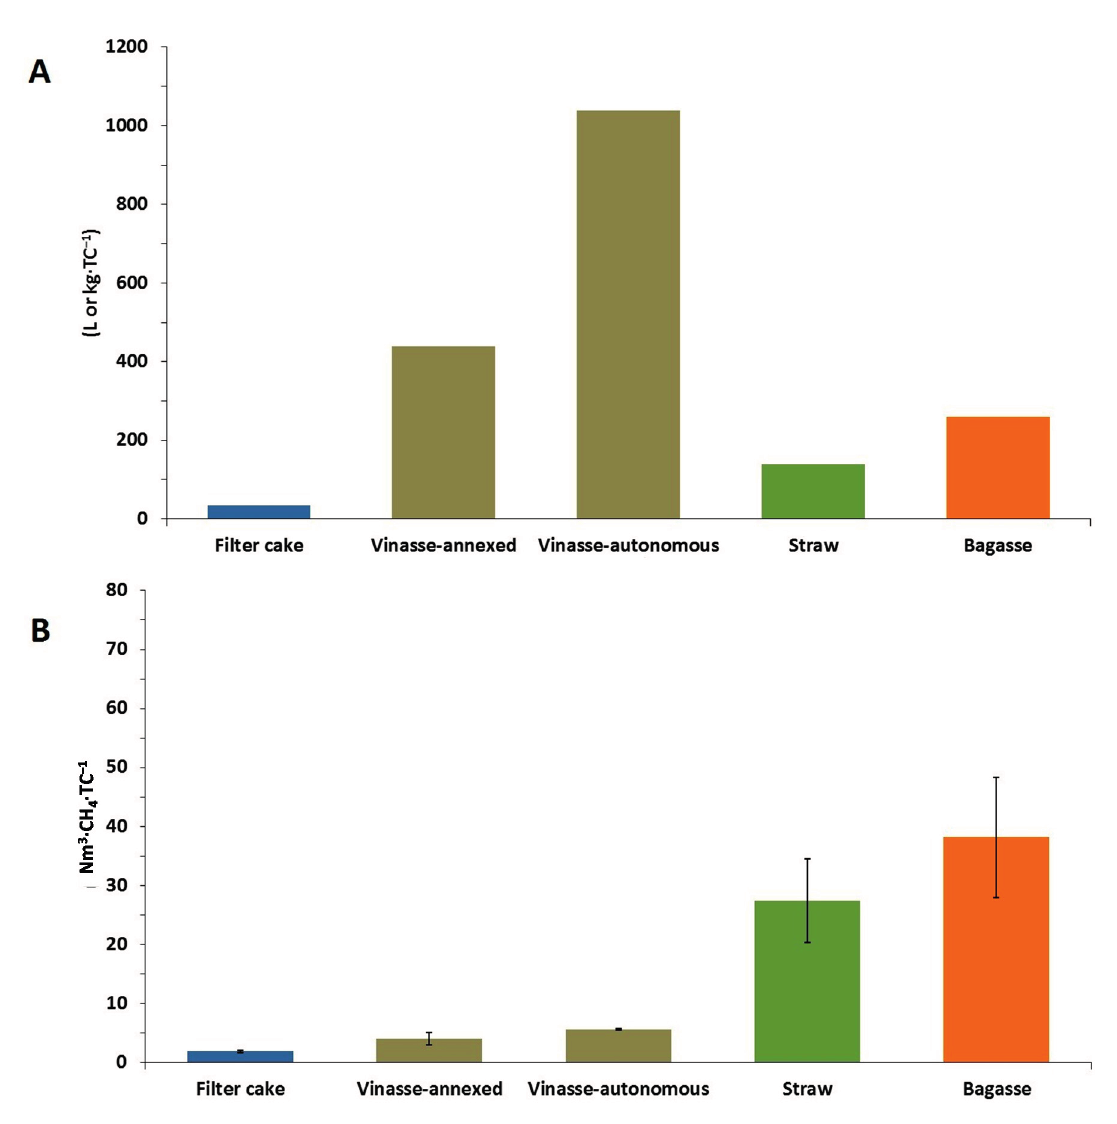
Figure 2. Mass flows VS energy potential of the sugarcane waste. ( A ) The values liters or kilogram per ton of cane (L or kg·TC − 1 ) refer to fresh matter according to data collected in two different sugarcane plants, except straw (dry matter) according to previous study [4]; ( B ) The values normal cubic meter of methane per ton of cane (Nm 3 ·CH 4 ·TC − 1 ) were calculated based on the BMP results and data presented in